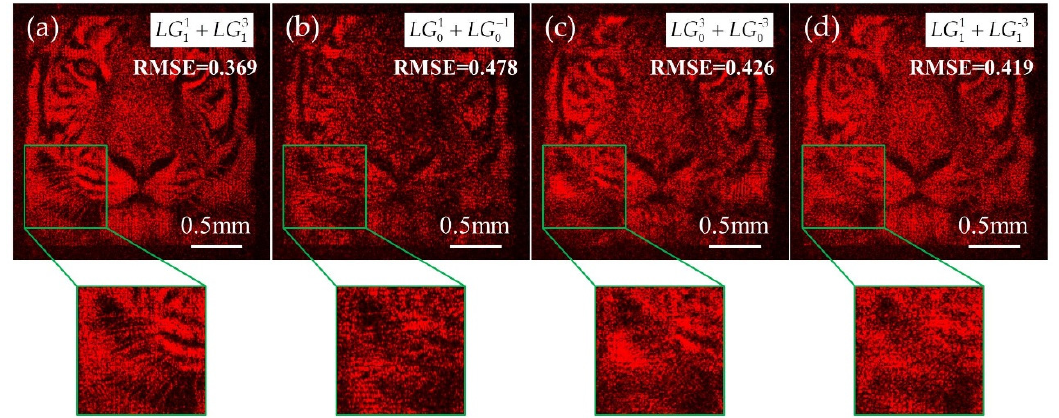
Figure 7. Experimental results of the CGH encoding grayscale image of a tiger. ( a ) The correct il- lumination of design was ( p 1 , l 1 ) = (1, 1) and ( p 2 , l 2 ) = (1, 3). The wrong illuminations used were ( b ) ( p 1 , l 1 ) = (0, 1) and ( p 2 , l 2 ) = (0, − 1), ( c ) ( p 1 , l 1 ) = (0, 3) and ( p 2 , l 2 ) = (0, − 3), and ( d ) ( p 1 , l 1 ) = (1, 1) and ( p 2 , l 2 ) = (1, − 3).